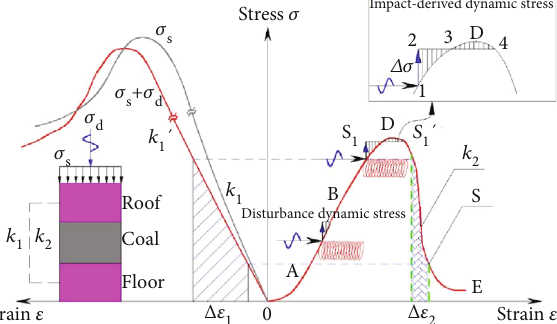
Figure 15: Energy transfer in roof-coal- fl oor system during the coal burst process under coupled static and dynamic